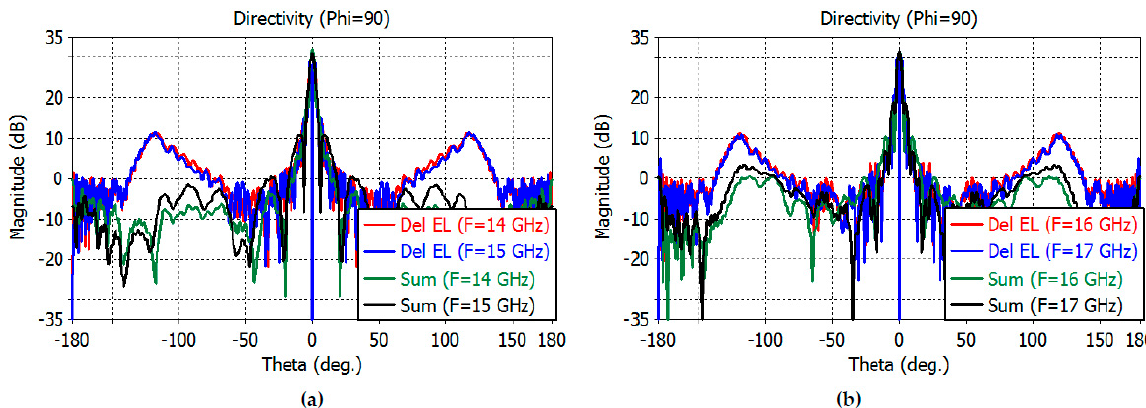
Figure 11. H -plane far-field directivity patterns of the sum channel at 14–15 GHz ( a ) and at 16–17 GHz ( b ).